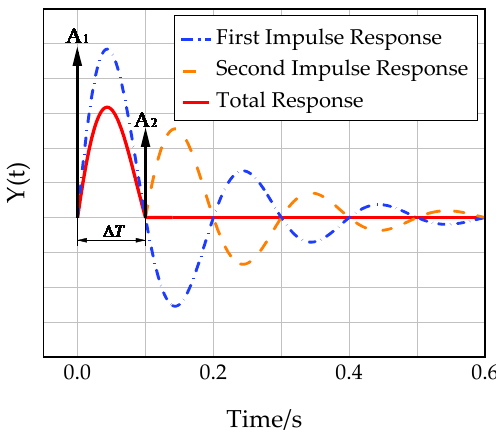
Figure 9. ZV input shaper impulse response.